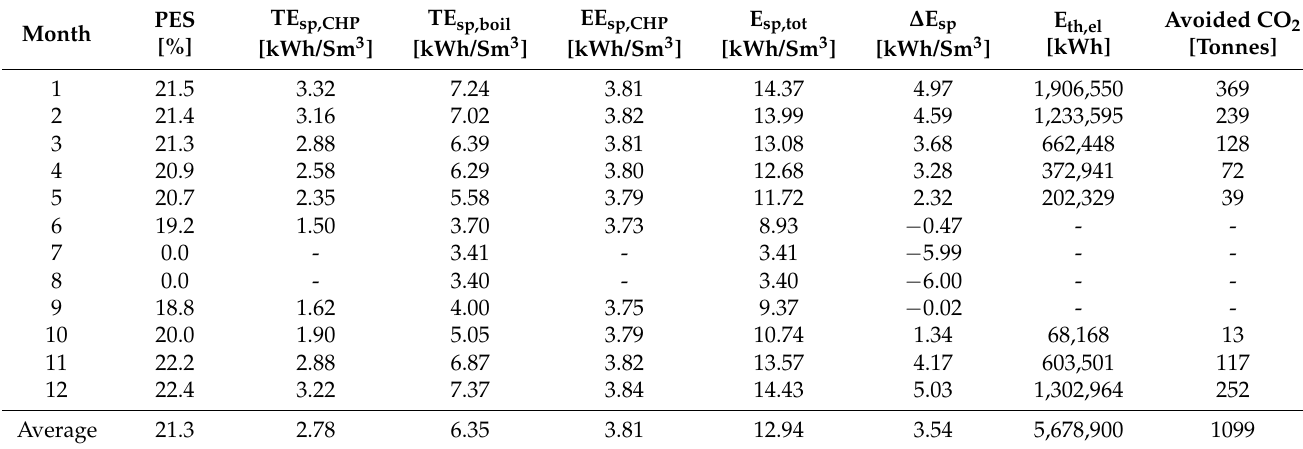
Table 6. Monthly specific energy parameters and the avoided CO 2 (year